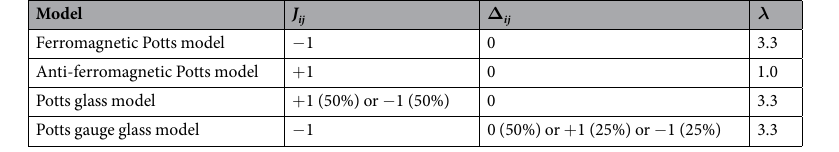
Table 1. Parameter settings of cost function Eq.